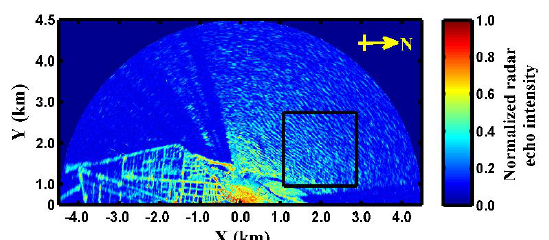
Figure 2. Comparison of Hs values obtained from radar images (in red) and buoy (in black)